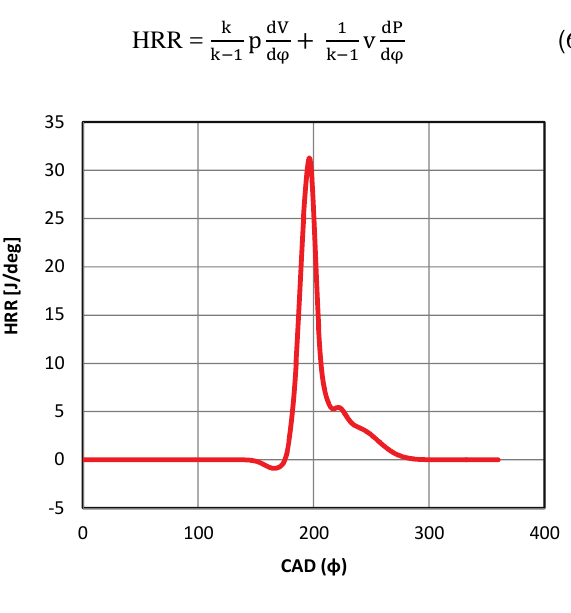
Fig. 5. Graph of heat release rate against